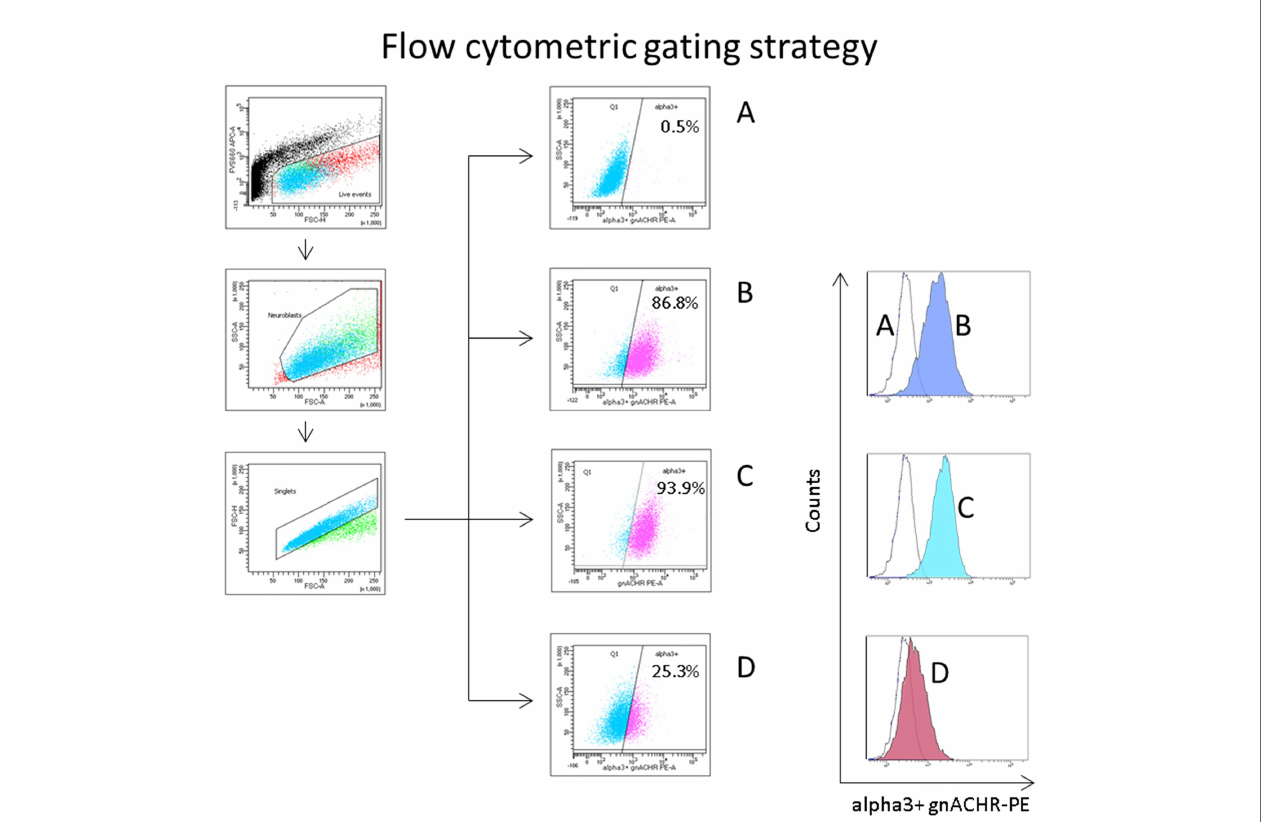
FIGURE 2 | Flow cytometric gating strategy to quantify autoantibody induced ganglionic acetylcholine receptor (gnACHR) internalization. Cells are gated on live events (FVS660-low, through the APC channel), then subgated on small ‘ neuroblast ’ events with doublets excluded. The amount of gnACHR remaining on the surface of cells after sample serum is added is quanti fi ed by the amount of mab35 (followed by a PE-conjugated anti-rat IgG antibody) staining evident. (Sample A ) incubated with Fetal Calf Serum (FCS), and only stained with a secondary antibody (unstained cells). Flow plots (middle of fi gure) display the percent of events positive for gnACHR as compared to the unstained cells. Histograms (to the right) display the same data. (Samples B – D ) incubated with serum and stained with both primary and secondary antibodies. (B) = FCS (maximally stained cells), (C) = (typical) healthy control serum, (D) = serum from a patient with con fi rmed seropositive Autoimmune Autonomic